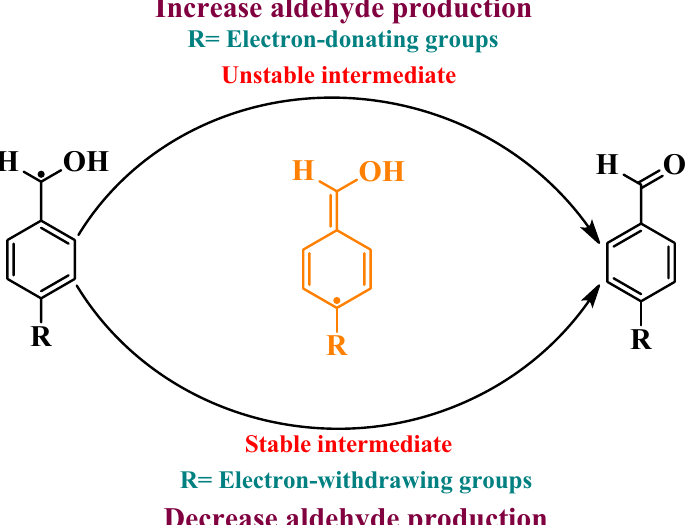
Figure 7. The effect of electron-withdrawing and electron-donating groups on aldehyde